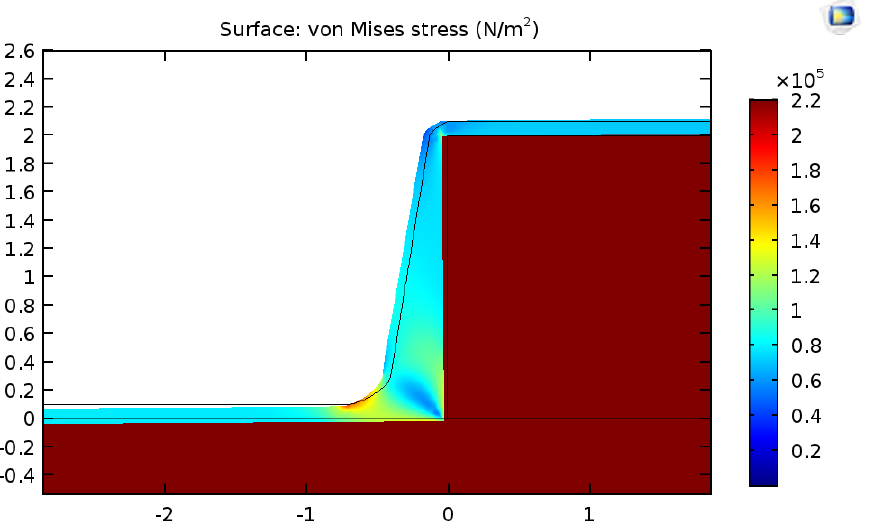
Figure 16. FEA modeling of conformal coating A stress distribution at 125 °C; x, y units are in mm. Table 9. Conformal coating max. local stress by 2D FEA modeling of chip attached to